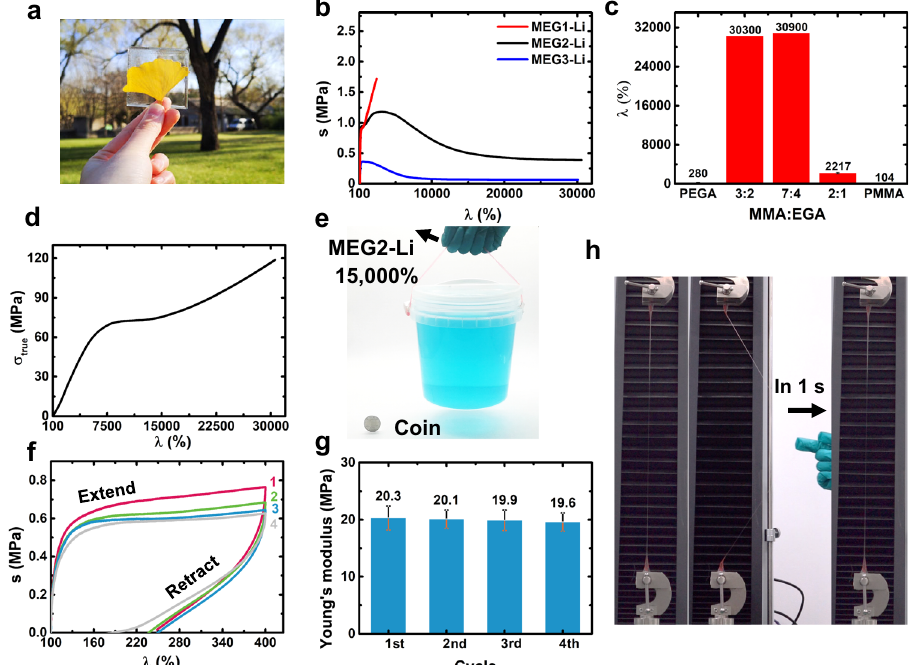
Fig. 3 Mechanical properties. a The transparent MEG2-Li. b Tensile tests for MEG1-Li, MEG2-Li, MEG3-Li. c Stretch ( λ ) plotted against molar ratios of MMA/EGA. d , True tensile stress-strain curves of MEG2-Li. e The photograph of MEG2-Li lifting a 1.5 kg bucket after 15,000% stretch. f Stress-strain cycling tests of MEG2-Li at the rate of 10 mm/min, the interval of each cycle was 60 min. g The statistics of Young ’ s modulus for each cycle in Fig. 3f, error bars represent standard deviation. h , The photograph of further laterally stretching the MEG2-Li with already 30,000%